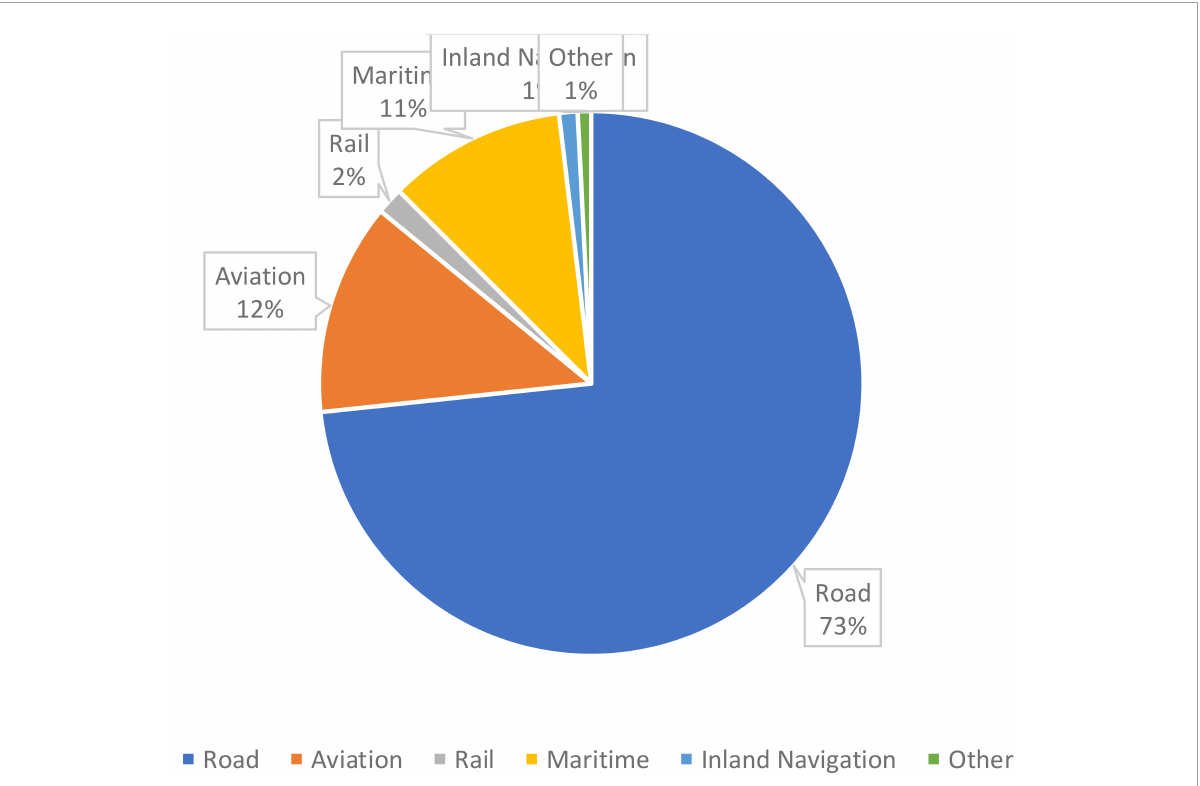
FIGURE2 Global transport sector greenhouse gas emissions by 2020. International Energy Association. IEA and IPCC (2014) Summary for